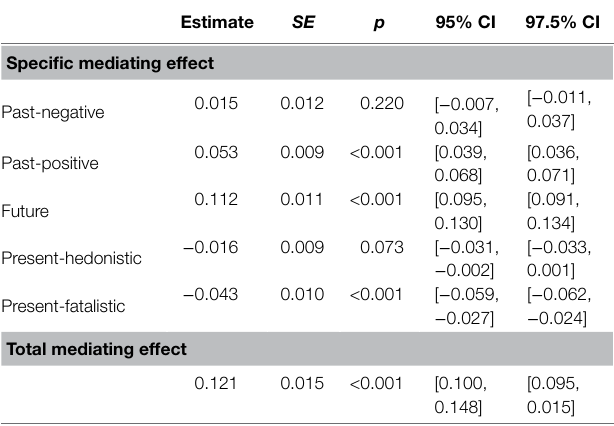
TABLE 2 | Mediating effects of time perspective between perfectionism and